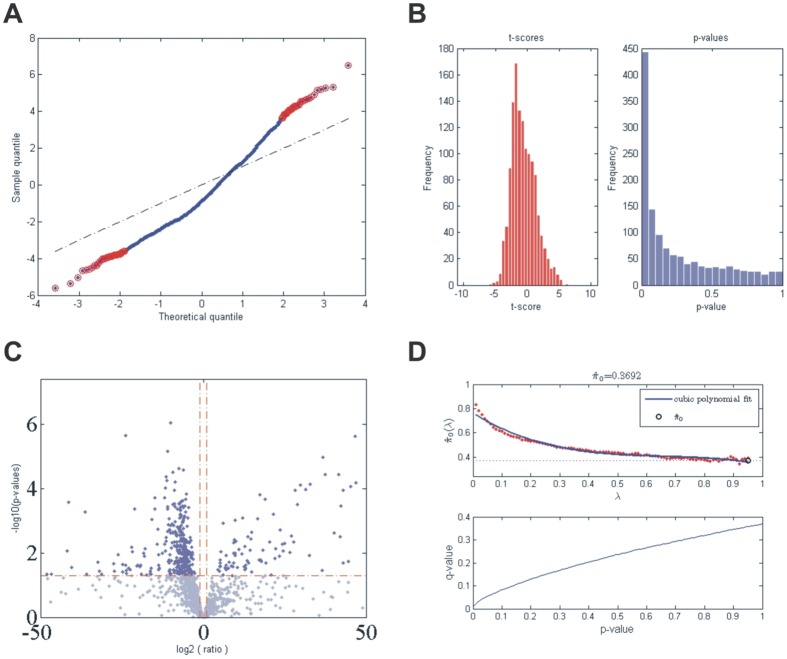
microRNA profiling.Four-hundred and thirty-four miRNAs were statistically significantly deregulated in all RCC subtypes and UT-UC versus the normal kidney. (A) Q-Q (quantile-quantile) plot. Red circles indicate the significantly deregulated miRNAs. (B) Frequencies of the t-scores and p-values. The deregulated miRNAs had a p<0.05. (C) The volcano-plot depicts the 434 statistically significantly deregulated miRNAs in ccRCC, papRCC, chRCC and UT-UC versus the normal kidney, of which the majority was significantly down-regulated in the cancerous tissue compared to the latter. (D) FDR diagram depicting the percentage of FDR with respect to p-value along with a plot of the estimated a priori probability that the null hypothesis π(0), is true versus the tuning parameter, lambda, λ, with a cubic polynomial fitting curve.